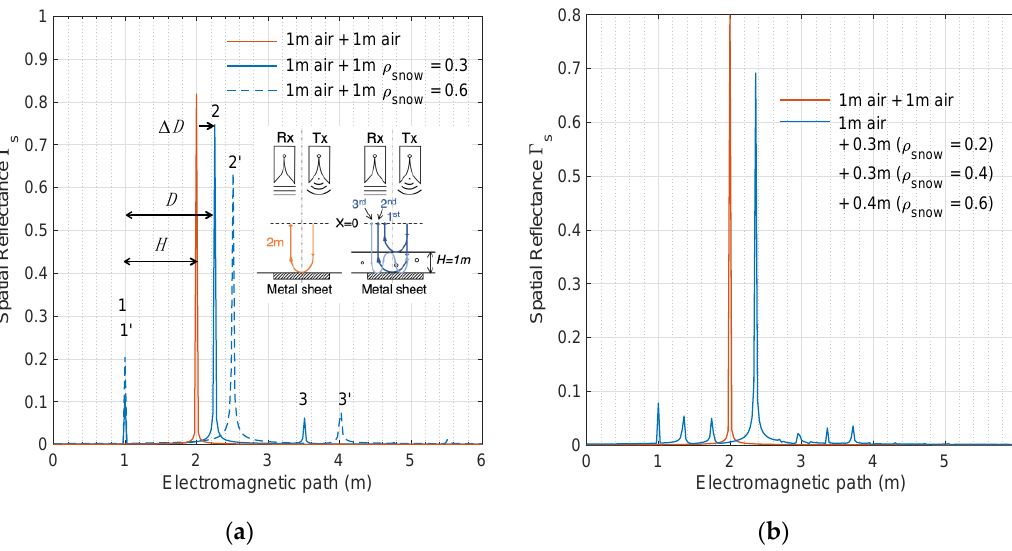
Figure 5. SFCW simulated spatial reflectances with the matrix method: ( a ) Signals for a 1 m of air and 1 m of snow layer with 0 (air), 0.3, and 0.6 relative densities. The orange line represents the reflectance of metal without a snow cover. ( b ) Air + three-layer structure with thicknesses [1,0.3,0.3,0.4] and relative densities [0,0.2,0.4,0.6]. We use an array format to describe the thicknesses and densities of layers.